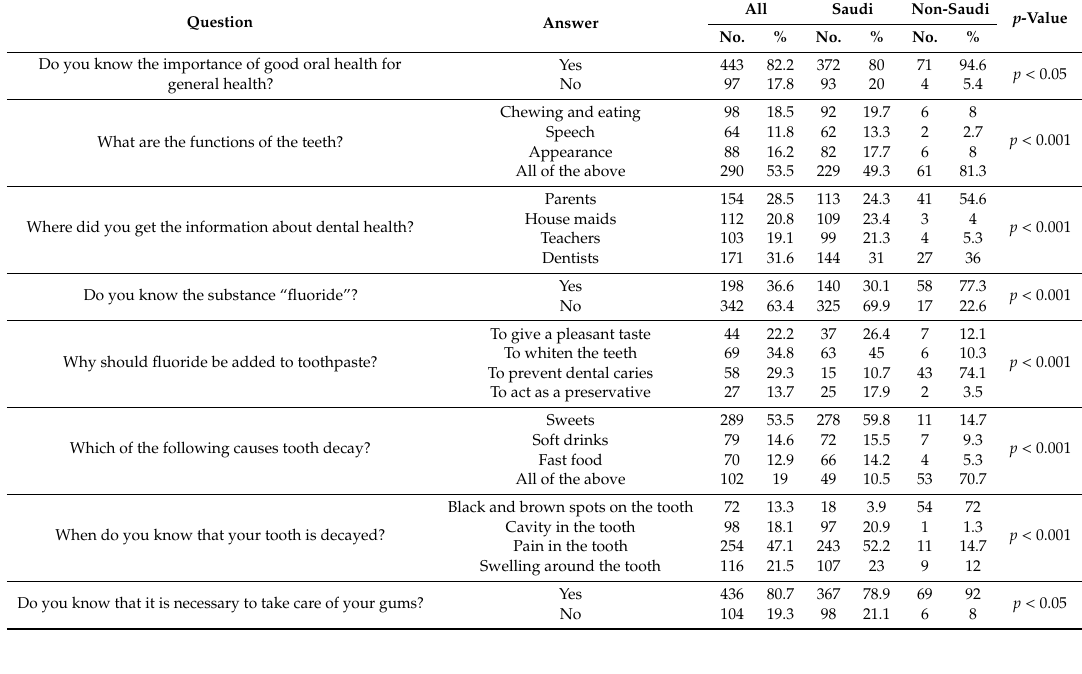
Table 2. Oral health knowledge.